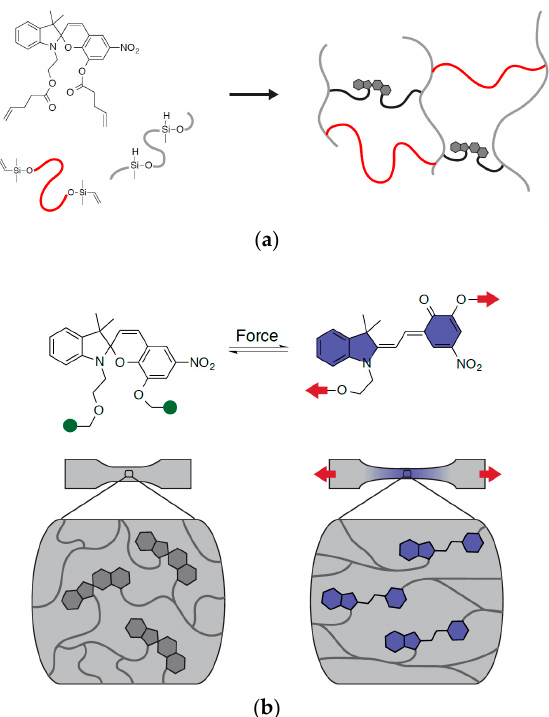
Figure 1. ( a ) Incorporation of SP (spiropyran) into PDMS (poly(dimethyl siloxane)) network structure. ( b ) Changing between SP and MC (merocyanine) during uniaxial mechanical deformation.